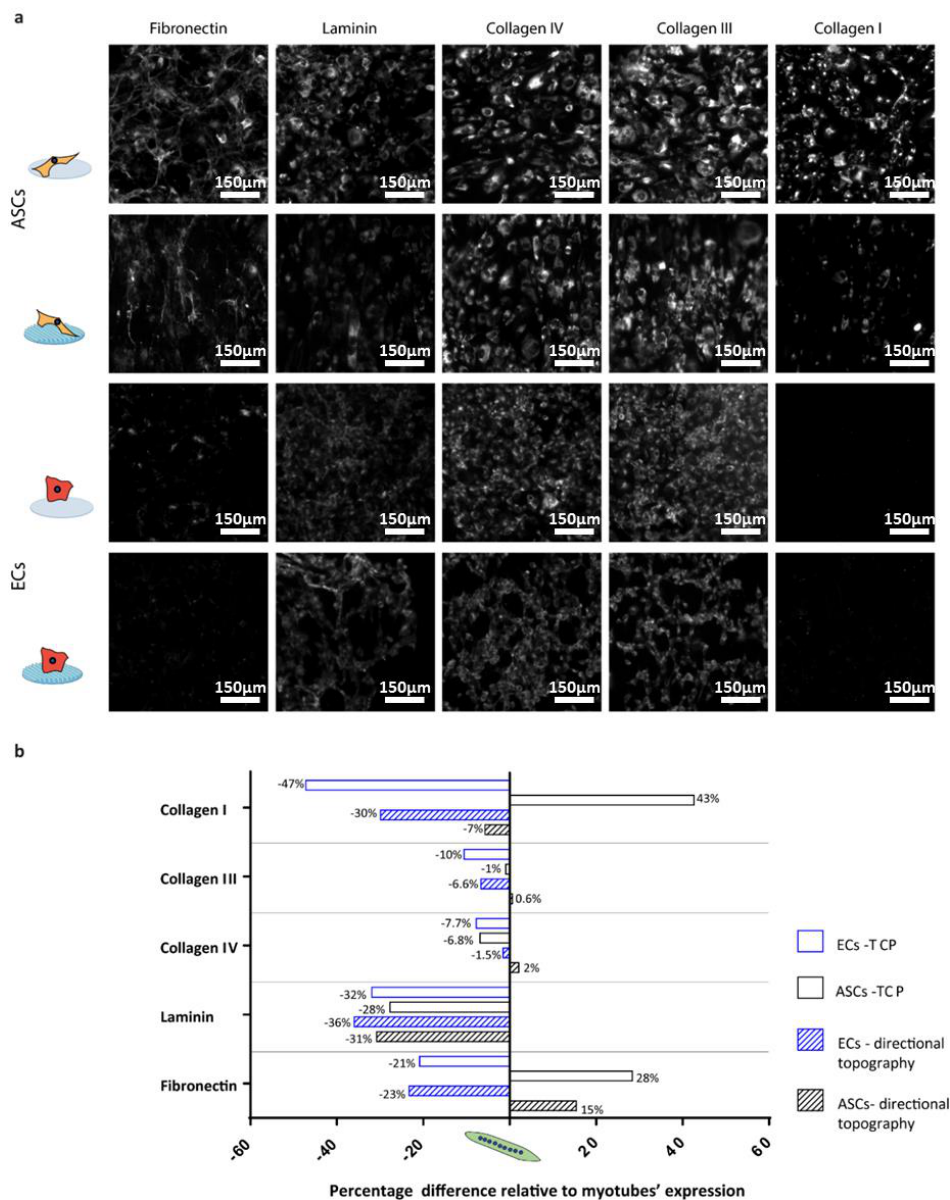
Figure 6. Percentage difference relative to myotubes expression: ( a ) Deposition of matrix protein of monocultures of ASCs and ECs on TCP and PDMS directional topographical surfaces after two days in culture. Scale bars are 150 µm. ( b ) Quantified fractions of deposited ECM protein, where negative means lower deposition by ECs or ASCs, while positive means lower deposition by myotubes. All depositions were compared to five-day-old myotubes (normalized with integrated density of the myotubes on TCP and directional topography).